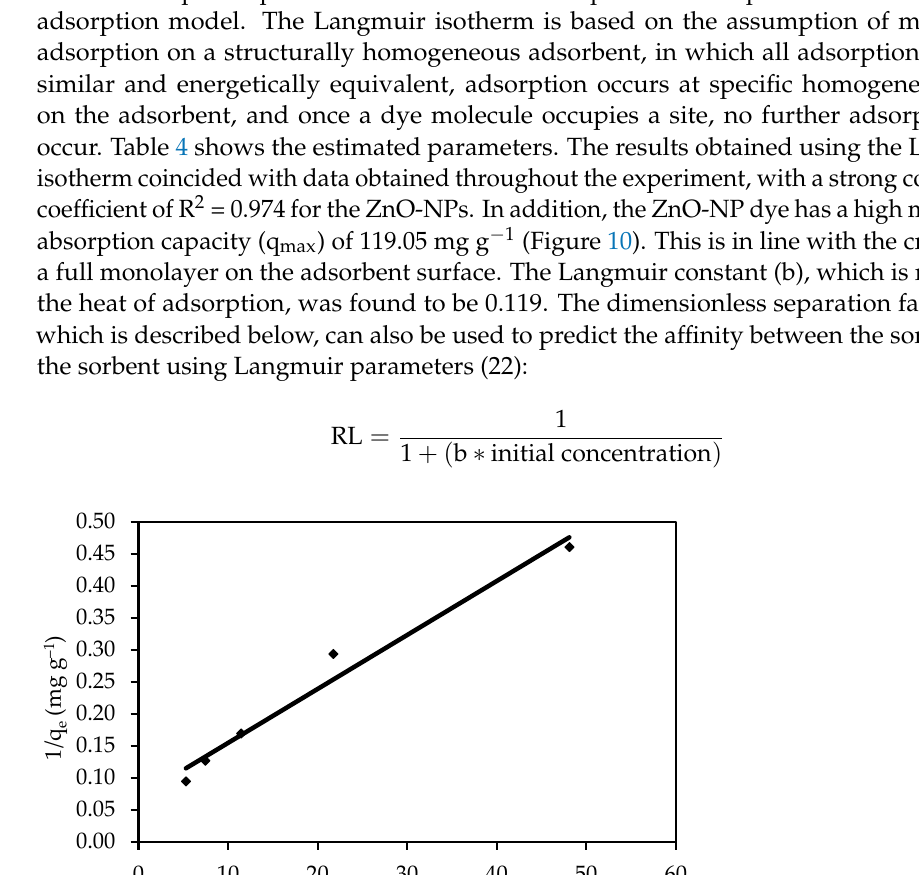
Figure 9. Freundlich isotherm of IV2R adsorption onto ZnO ‐ NPs.